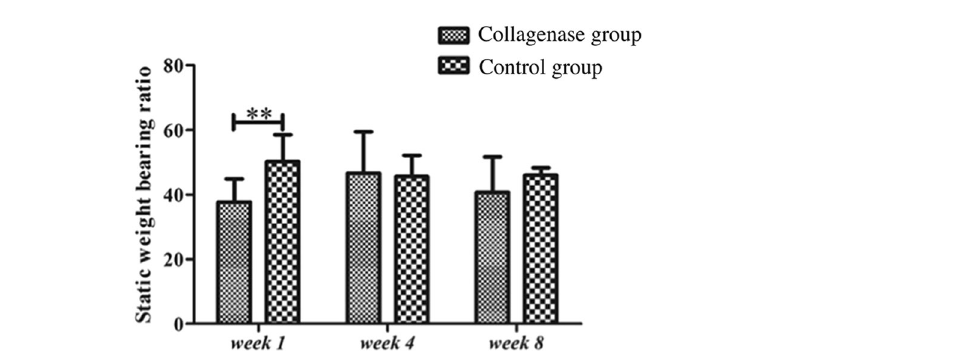
Figure 3. The force values of the three axes in the rat gait analysis. The left hindlimbs were injected with collagenase (Collagenase group) or given only needle punctures (Sham Control group). The right hindlimbs were given no treatment (internal controls). ( a ) Fz, vertical direction; ( b ) Fy, inward (negative)/outward (positive) direction (value); ( c ) Fz, forward (negative)/backward (positive) direction (value). * Compared with contralateral forelimbs and hindlimbs; * p < 0.05; ** p < 0.01.